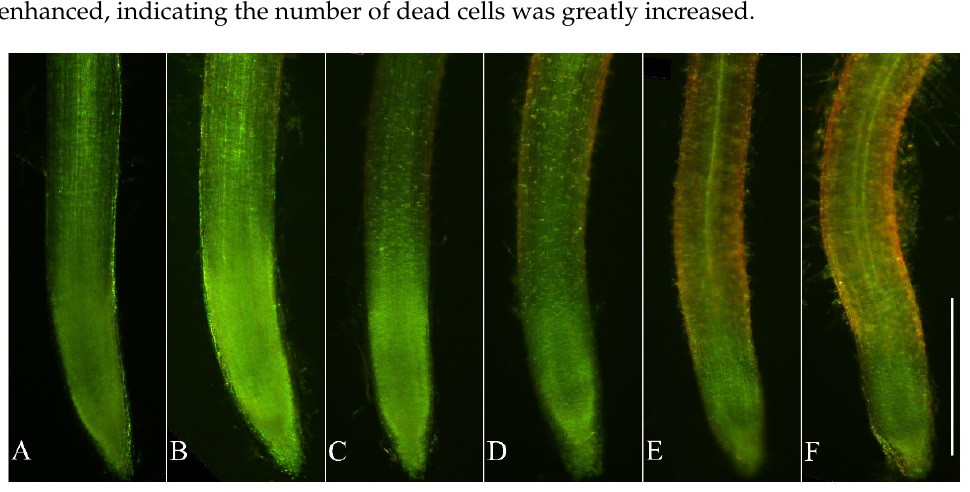
Figure 5. Relative Evans blue uptake of lettuce seedlings after treatments with acacetin. The results presented are mean of three replicates ± SE, different letters denote significant differences at p < 0.05 according to one-way ANOVA with an LSD test. 3.5. ROS Production and Lipid Peroxidation in Lettuce Seedlings after Treatments with Acacetin After staining with DHE, the bright fluorescence, which mainly represents O 2 − , was induced at 1 μ M acacetin, while the fluorescence was enhanced at 10 μ M acacetin. Then, with the increasing acacetin concentration, the fluorescence intensity in lettuce roots was rapidly enhanced. At high concentrations of 500 μ M, there was very strong fluorescence in the treated roots (Figure 6).